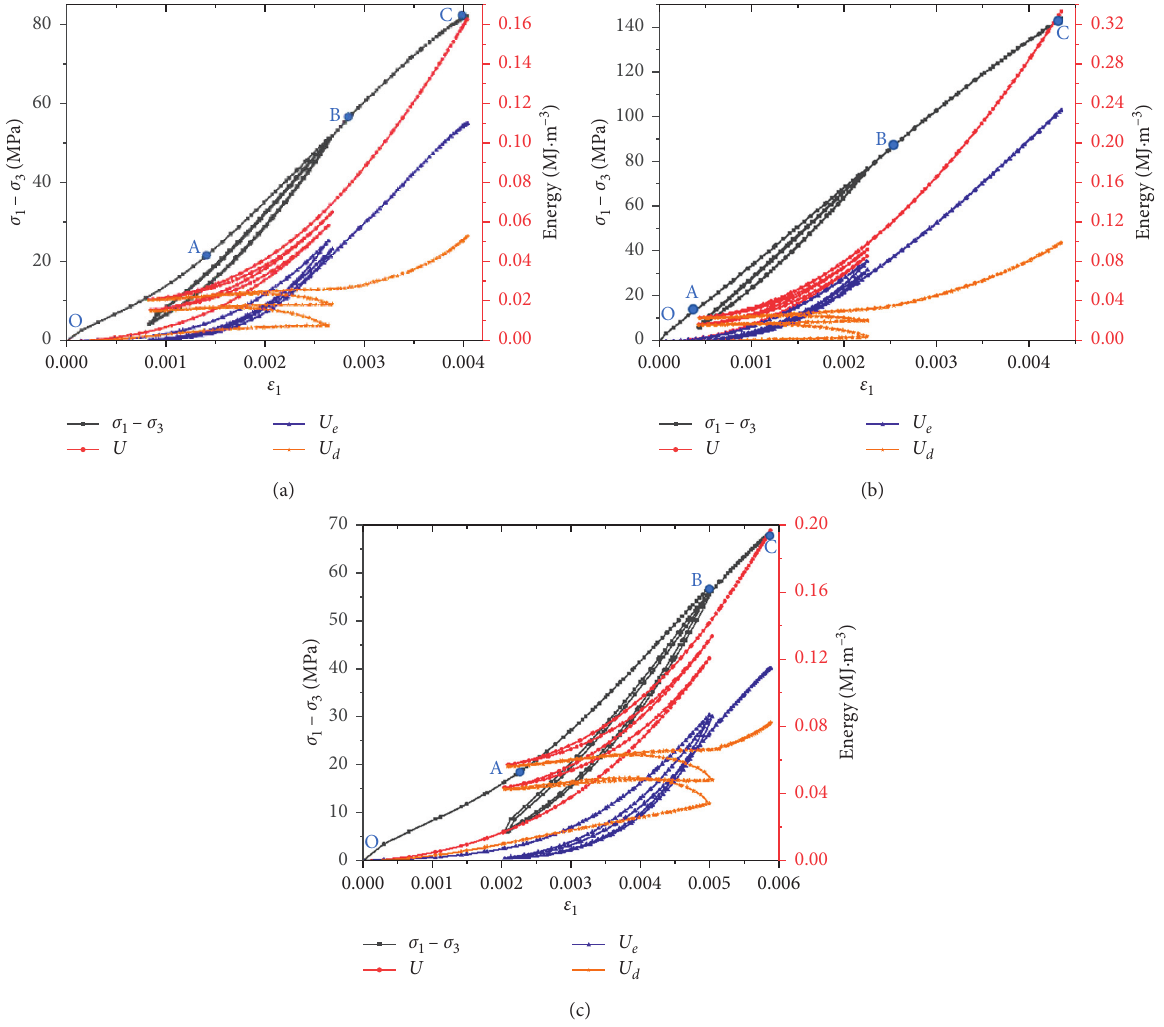
Figure 5: Energy evolution of sandstones during uniaxial loading-unloading: (a) US1; (b) US2; (c)